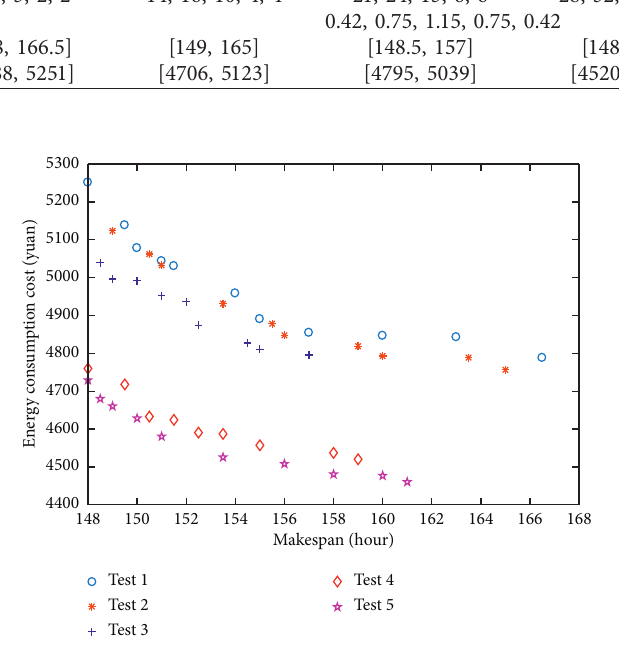
Figure 17: Pareto fronts by different periods of TOU electricity